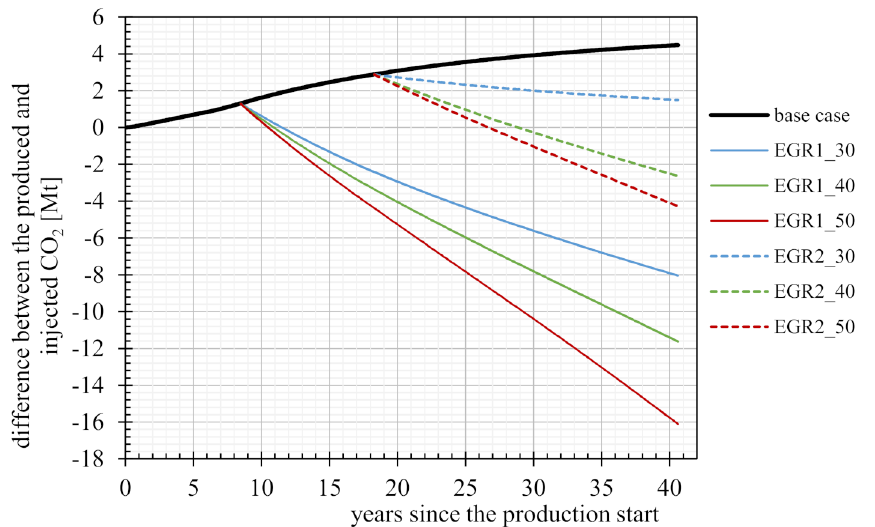
Figure 5. Difference between the produced and injected CO 2 .